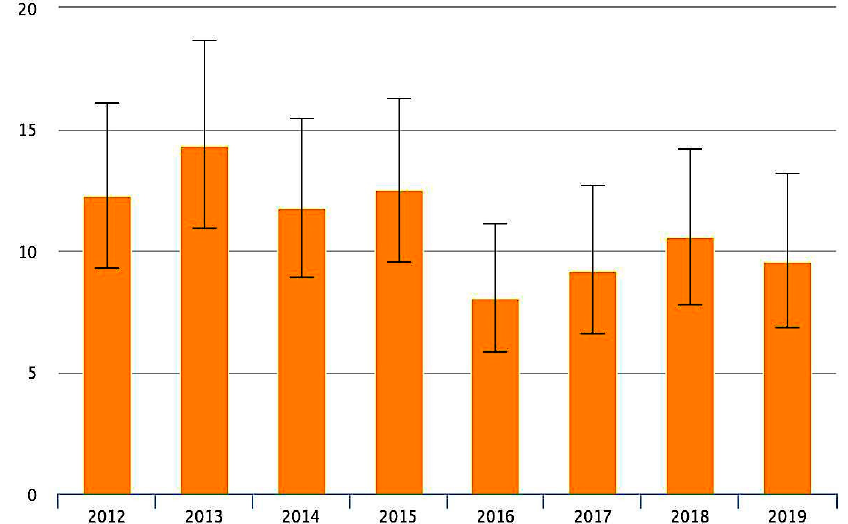
Figure 3. Number of acute ischemic stroke admitted in the spoke hospital of Santa Maria della Stella Hospital in Orvieto from 2012 to 2019.